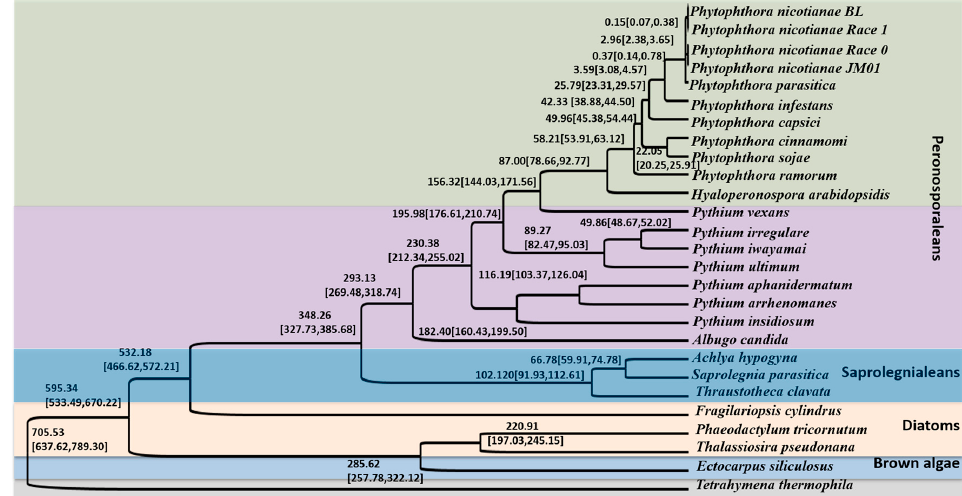
Figure 1. Phylogenetic relationships of Ph. nicotianae JM01and other species based on the dataset of common single copy genes. This phylogenetic tree was generated using Bayesian inference in BEAST v1.7.5. The time scale was set according to the divergence time between T. clavata and Py. infestans (~363 Ma). The divergence time of each species was marked above each branch with 95% confidence level. Different colors represent different groups.